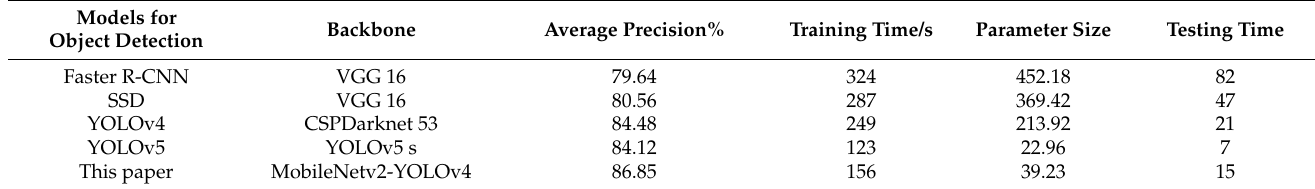
Table 9. Performance comparison of different object detection